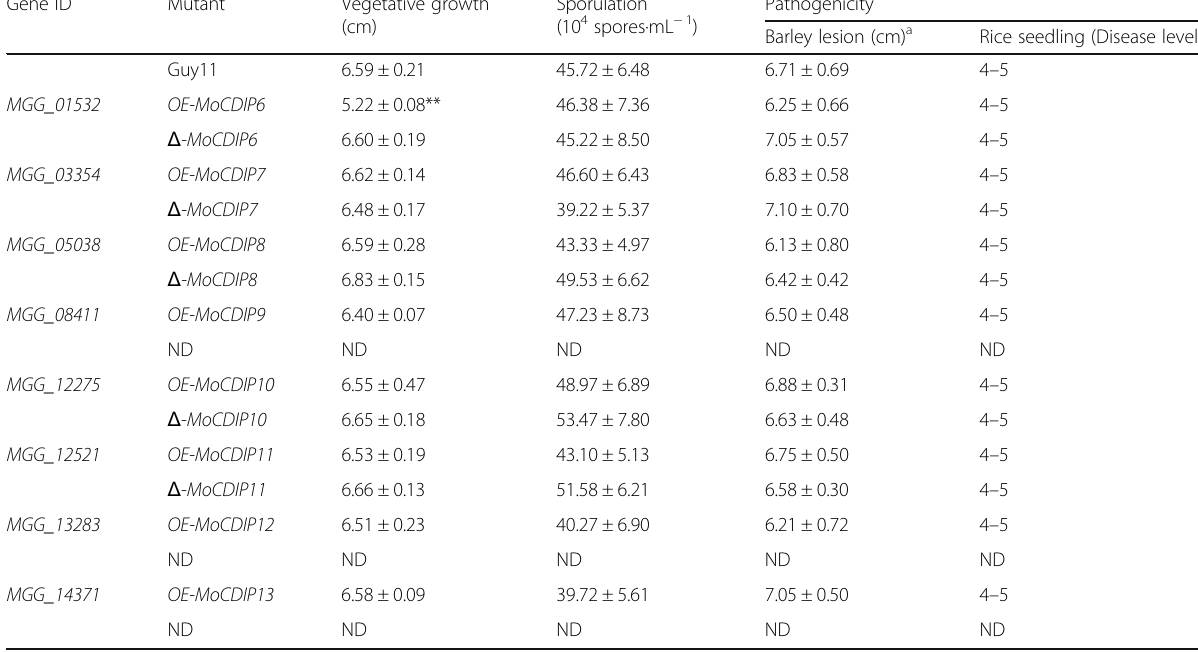
Table 1 Assays of growth, sporulation, and pathogenicity of the MoCDIPs overexpression and knock out mutants Gene